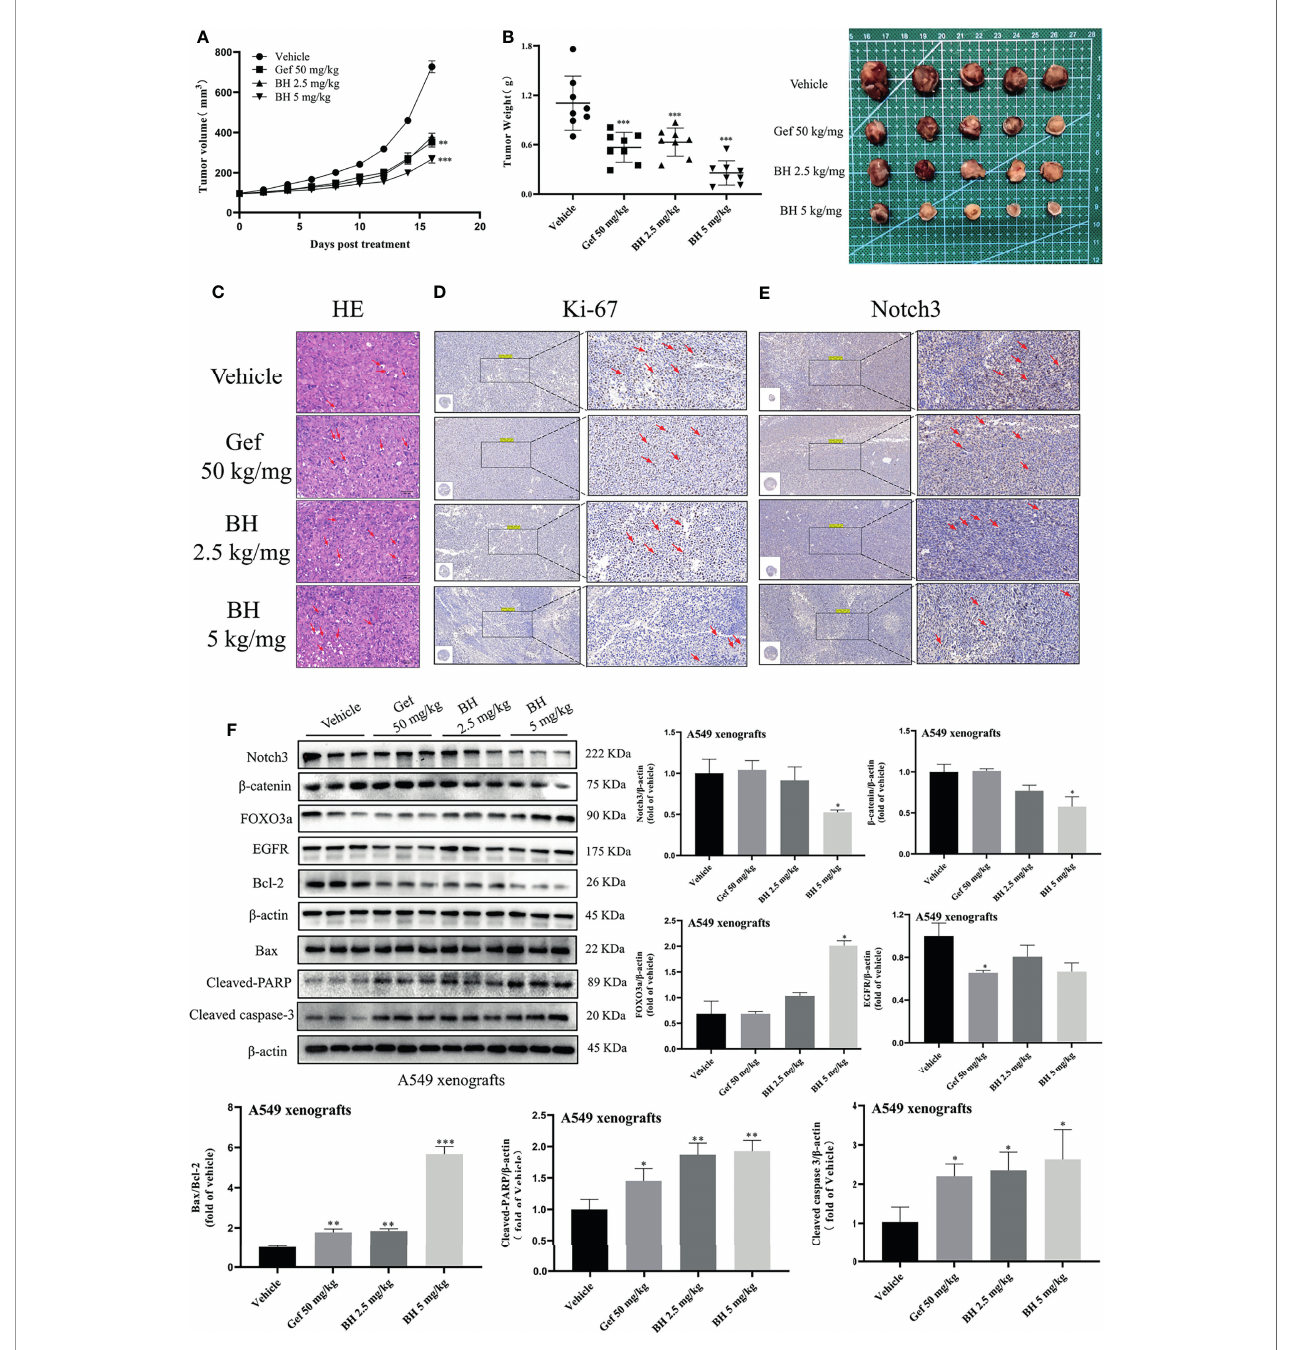
FIGURE 7 | BH inhibits the growth of lung cancer xenografts in BALB/c athymic nude mice. (A, B) Tumor volume and tumor weight. (C) H&E staining of tumor tissues, and the scale bar was 100 m m. (D, E) IHC was used to detect the protein levels of Ki-67 and Notch3 of A549 xenografts, and the scale bar was 200 m m. (F) Protein levels of Notch3, b -catenin, FOXO3a, EGFR, Bcl-2, Bax, cleaved caspase-3, and cleaved-PARP in tumor samples were determined by Western blot. “ * ” represents Gef +BH group, BH group, Gef group vs. the group (*p < 0.05, **p < 0.01, ***p<